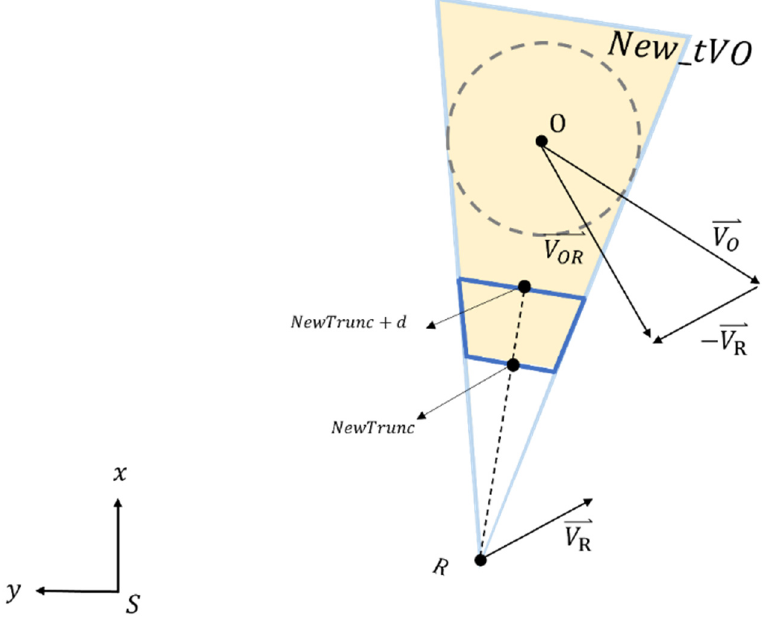
Figure 12. Consideration of velocity in the cutting-off distance.